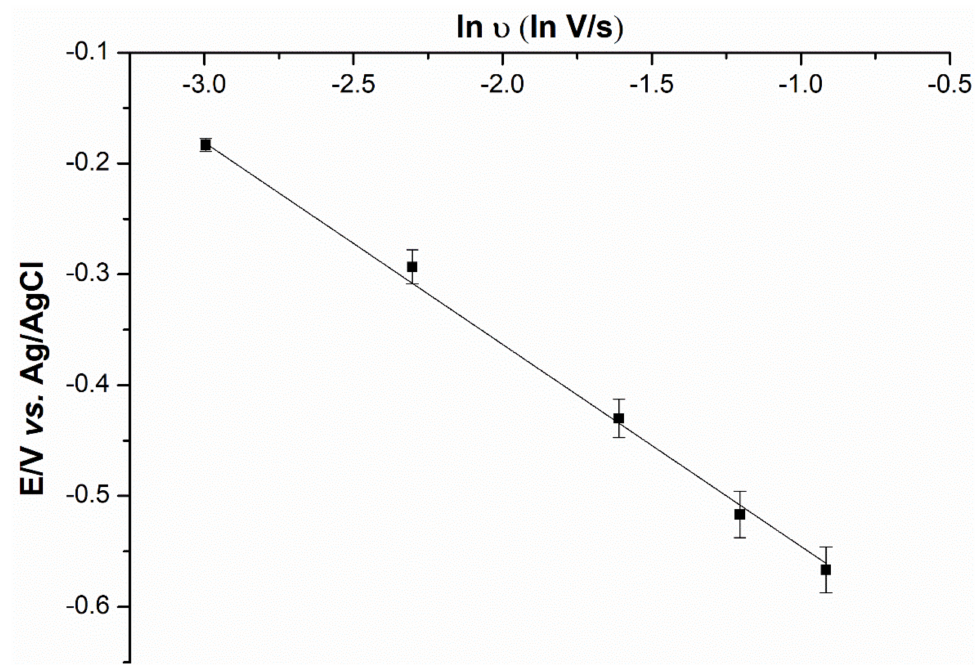
Figure 9. The peak potential ( E ) against the natural logarithm of scan rate (ln υ ) for the voltammogram of 125 ppm cadmium(II) in 0.1 mM HCl solution ( n =